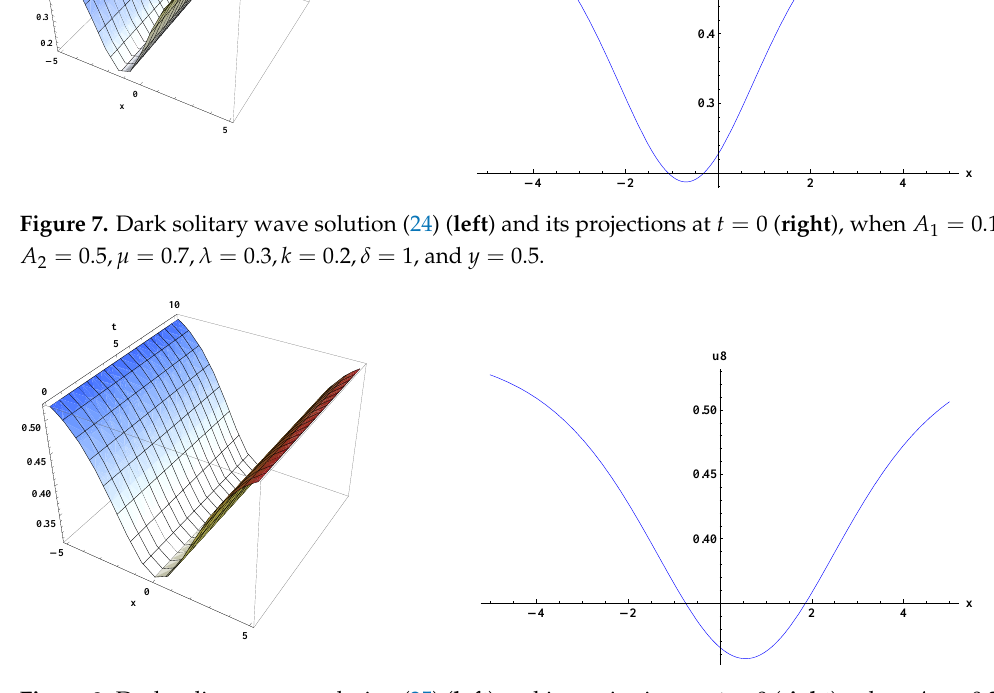
Figure 8. Dark solitary wave solution (25) ( left ) and its projections at t = 0 ( right ), when A 1 = 0.2, A 2 = 0.9, µ = − 0.3, λ = 0.4, k = 0.2, δ = 1, and y = 0.5.